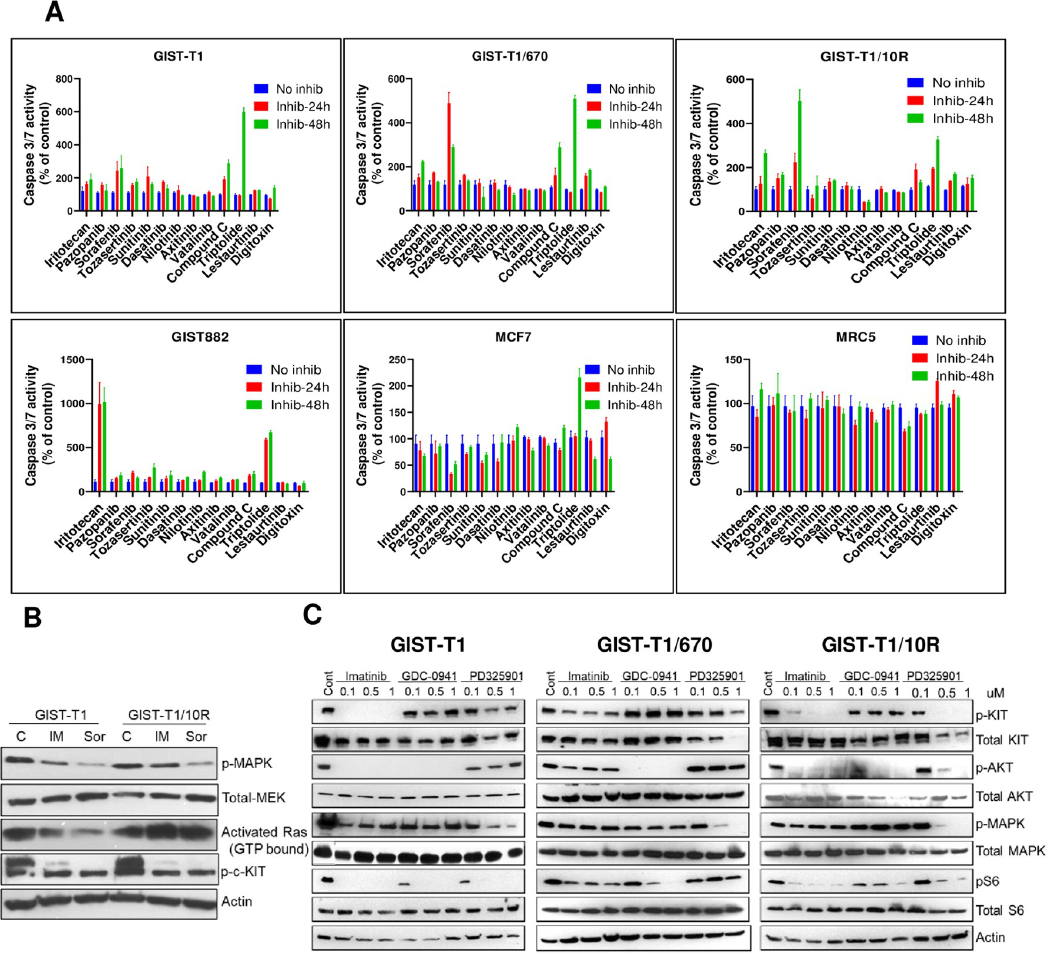
Fig 1. Imatinib resistant cell lines have activated MAPK pathway. (A) Caspase 3/7 activity of selected compounds in imatinib- sensitive and -resistant GIST cell lines. Cells lines were treated with irinotecan (0.5 μ M), pazopanib, tozasertinib, sunitinib, dasatinib, nilotinib, vatalinib, lestauritinib, digitoxin (1 μ M), sorafenib (500 nM), axitinib (500 nM), compound C (5 μ M), or triptolide (25 nM) for 24 h and 48 h and caspase 3/7 activity was measured. The data is represented as % of control; each bar represents the mean of triplicates. (B) Constitutively active Ras in GIST-T1/10R is not inhibited by KIT inhibitors. GIST-T1 and GIST-T1/10R cell lines were treated with 1 μ M of imatinib and 500 nM of sorafenib and activated RAS and MAPK levels were measured by western blot. (C) Dose response of imatinib, GD and PD in GIST cell lines. Cells were treated with inhibitors at indicated concentrations for 24 h. Cell lysates from GIST-T1, GIST-T1/670 and GIST-T1/10R cells were analyzed by western blot to detect the total and phosphorylated levels of the indicated